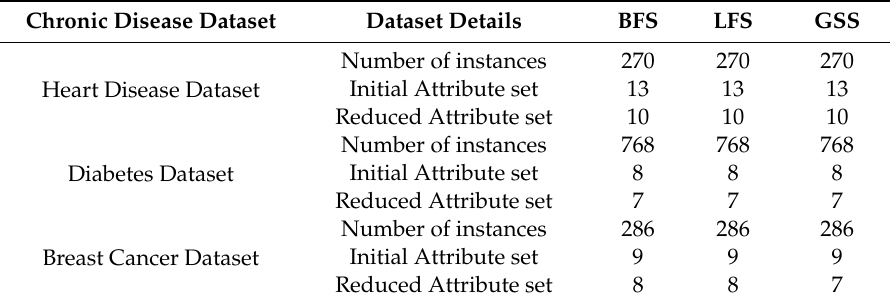
Table 10. The impact of the wrapper methods on disease datasets. Chronic Disease Dataset